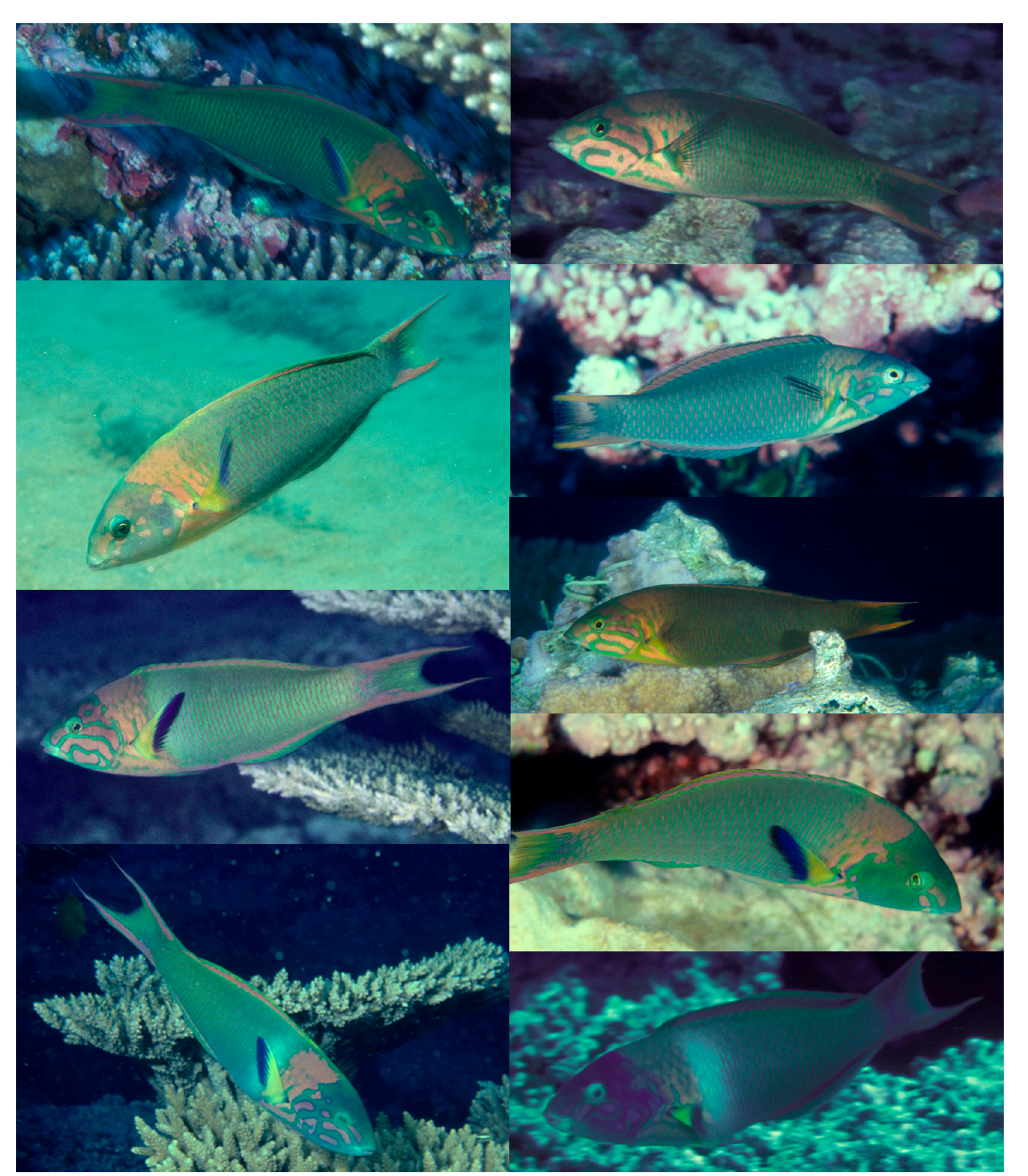
Figure 3. Hybrid Thalassoma duperrey X lutescens variations at Johnston Atoll.